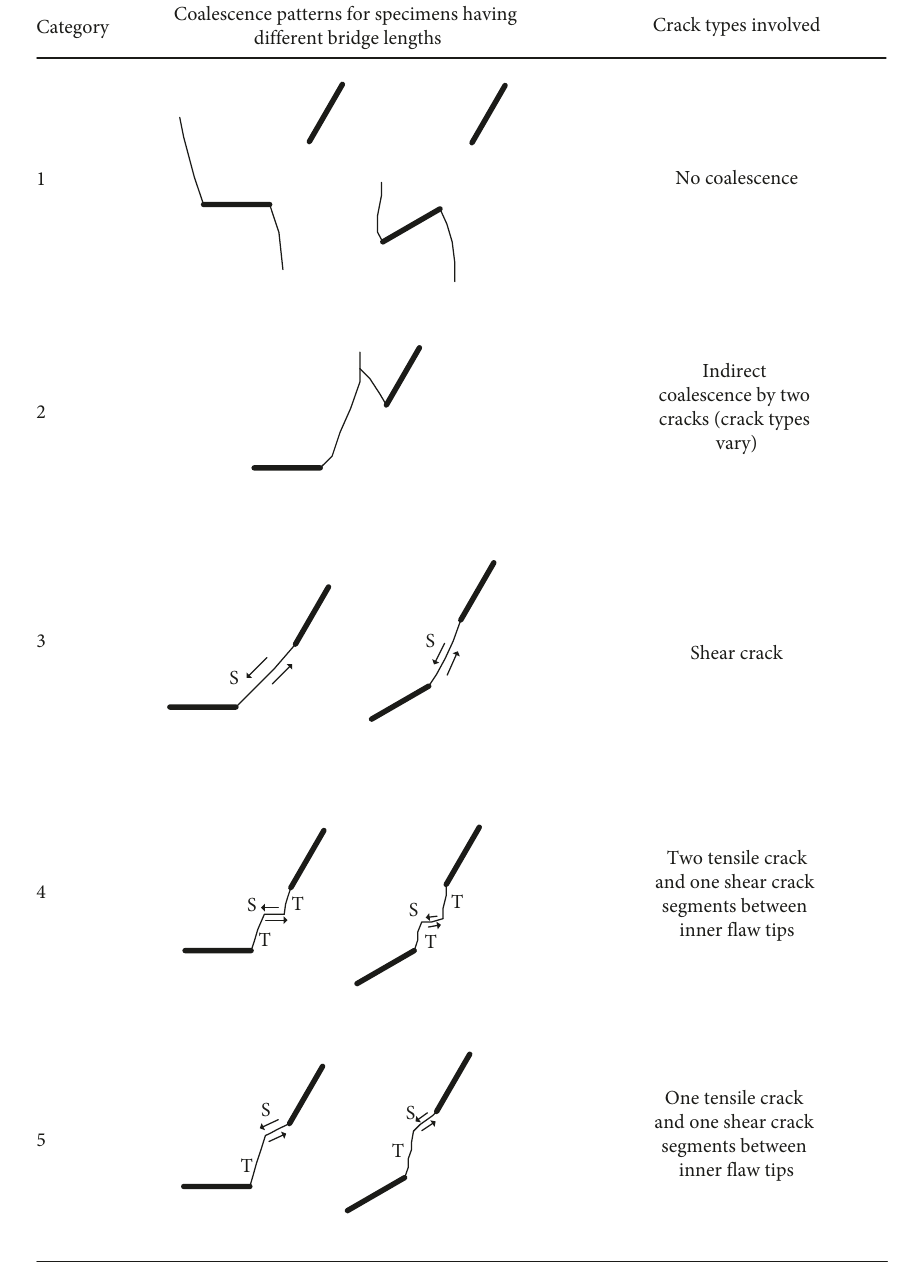
Figure 7: Types of coalescence in triaxial compression for specimens with geometries of 2 b -0-60-60 and specimens 2 b -30-60-60 with different bridge